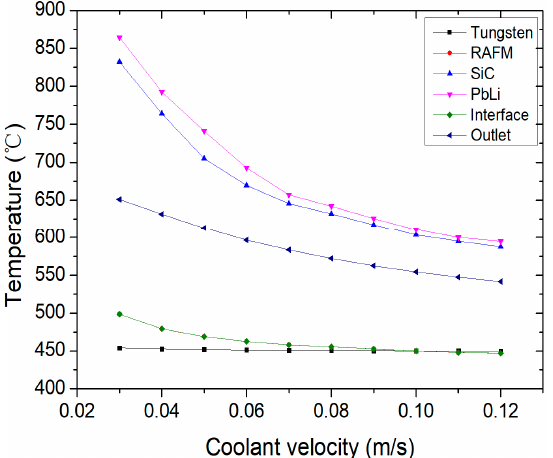
Energies 2021 , 14 , 6350 Figure 13. Variation of maximum temperature versus different coolant inlet velocity.